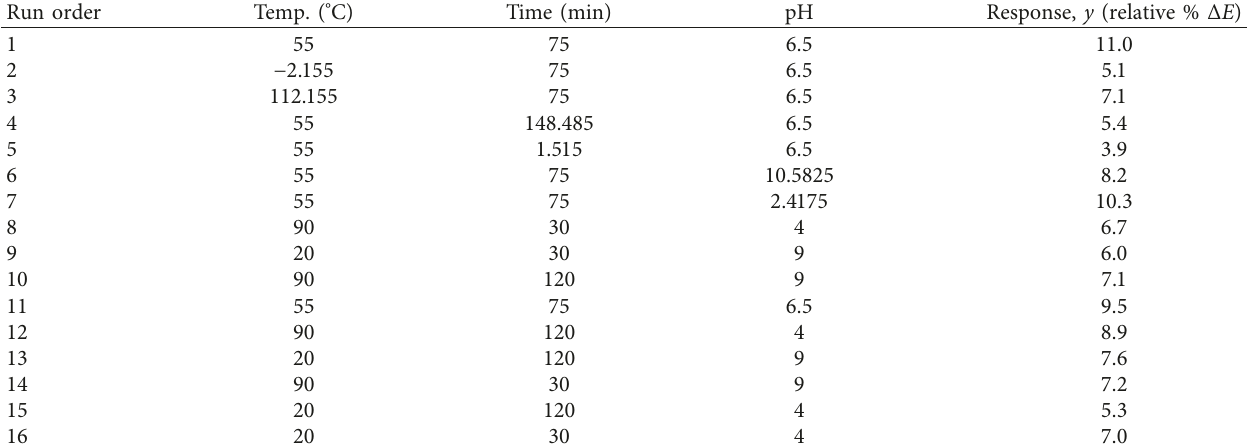
Table 2: Experiments planned in CCD for dyeing optimization and response ( y ).